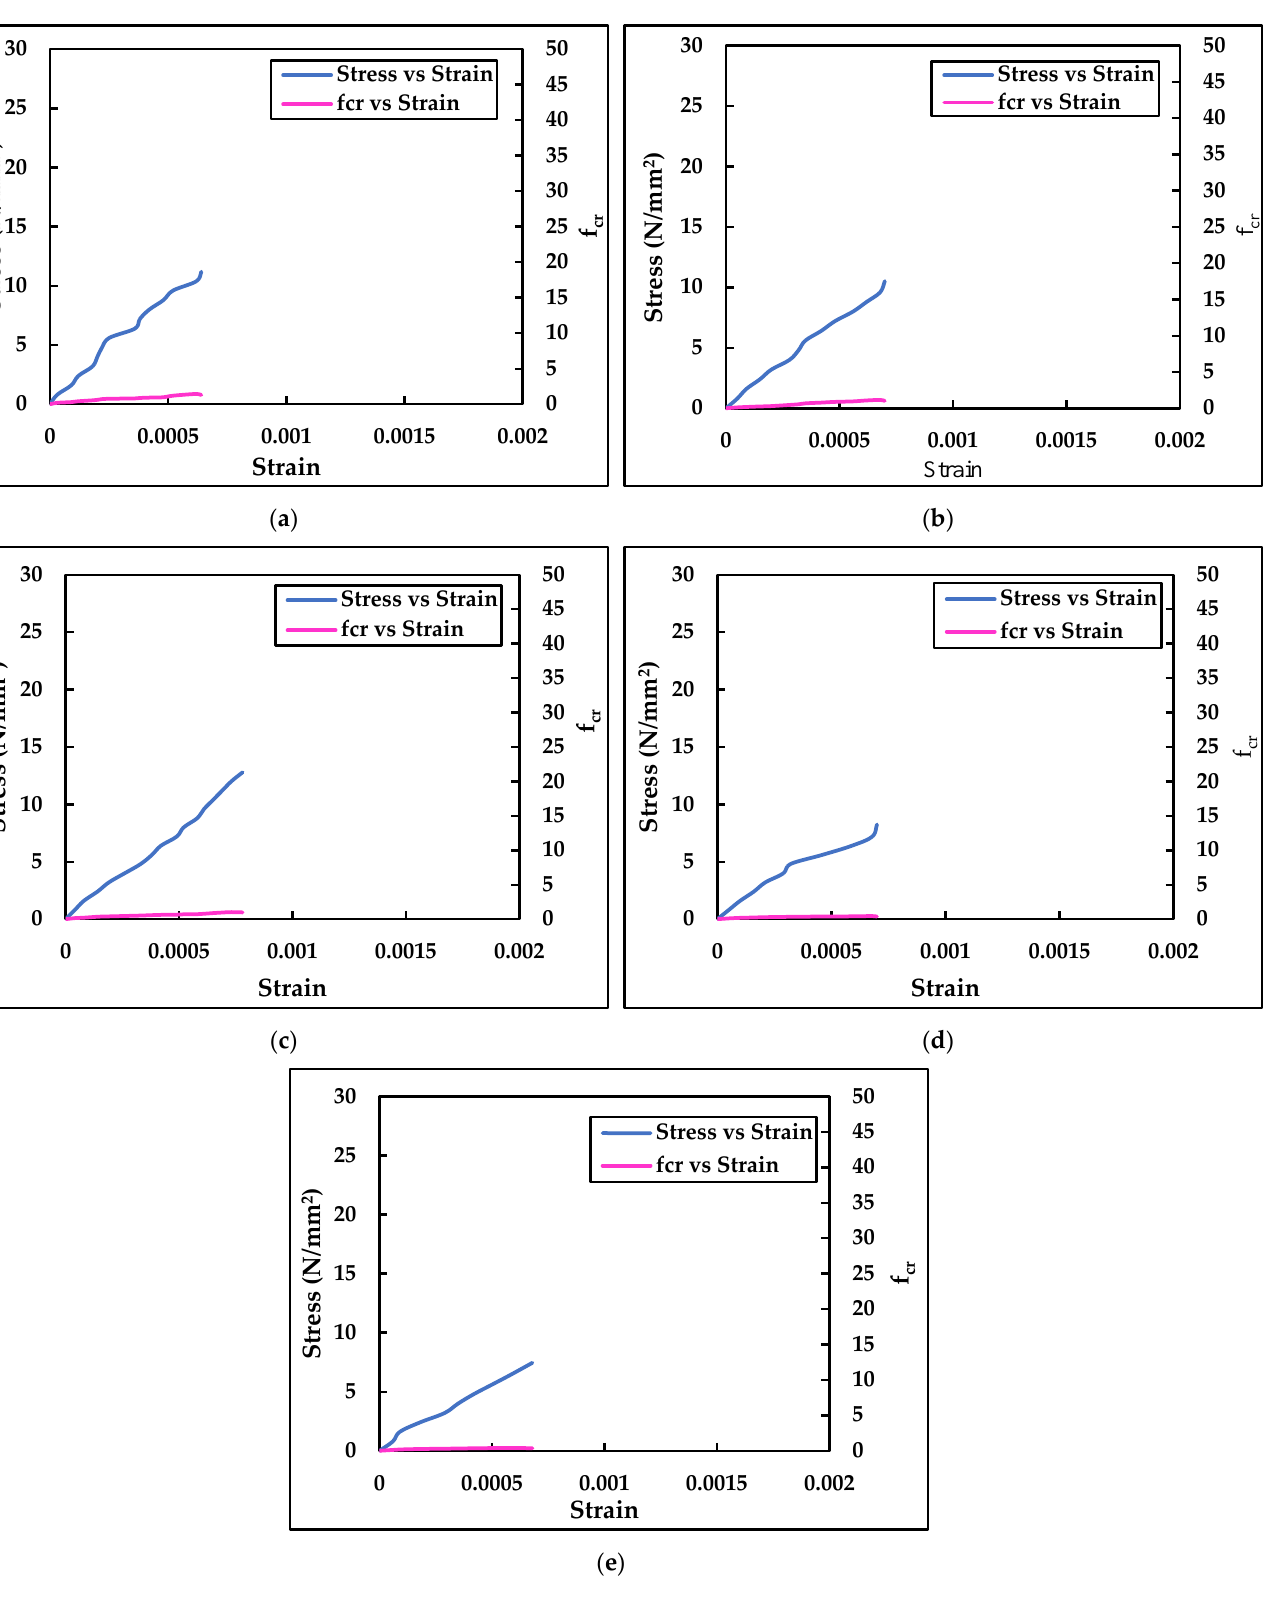
Figure 15. Graphical illustration of stress vs. strain and fcr vs. strain for conventional mortar cube after 28 days of water curing subjected to elevated temperatures. ( a ) Room temperature; ( b ) 200 °C; ( c ) 400 °C; ( d ) 600 °C; ( e ) 800 °C.